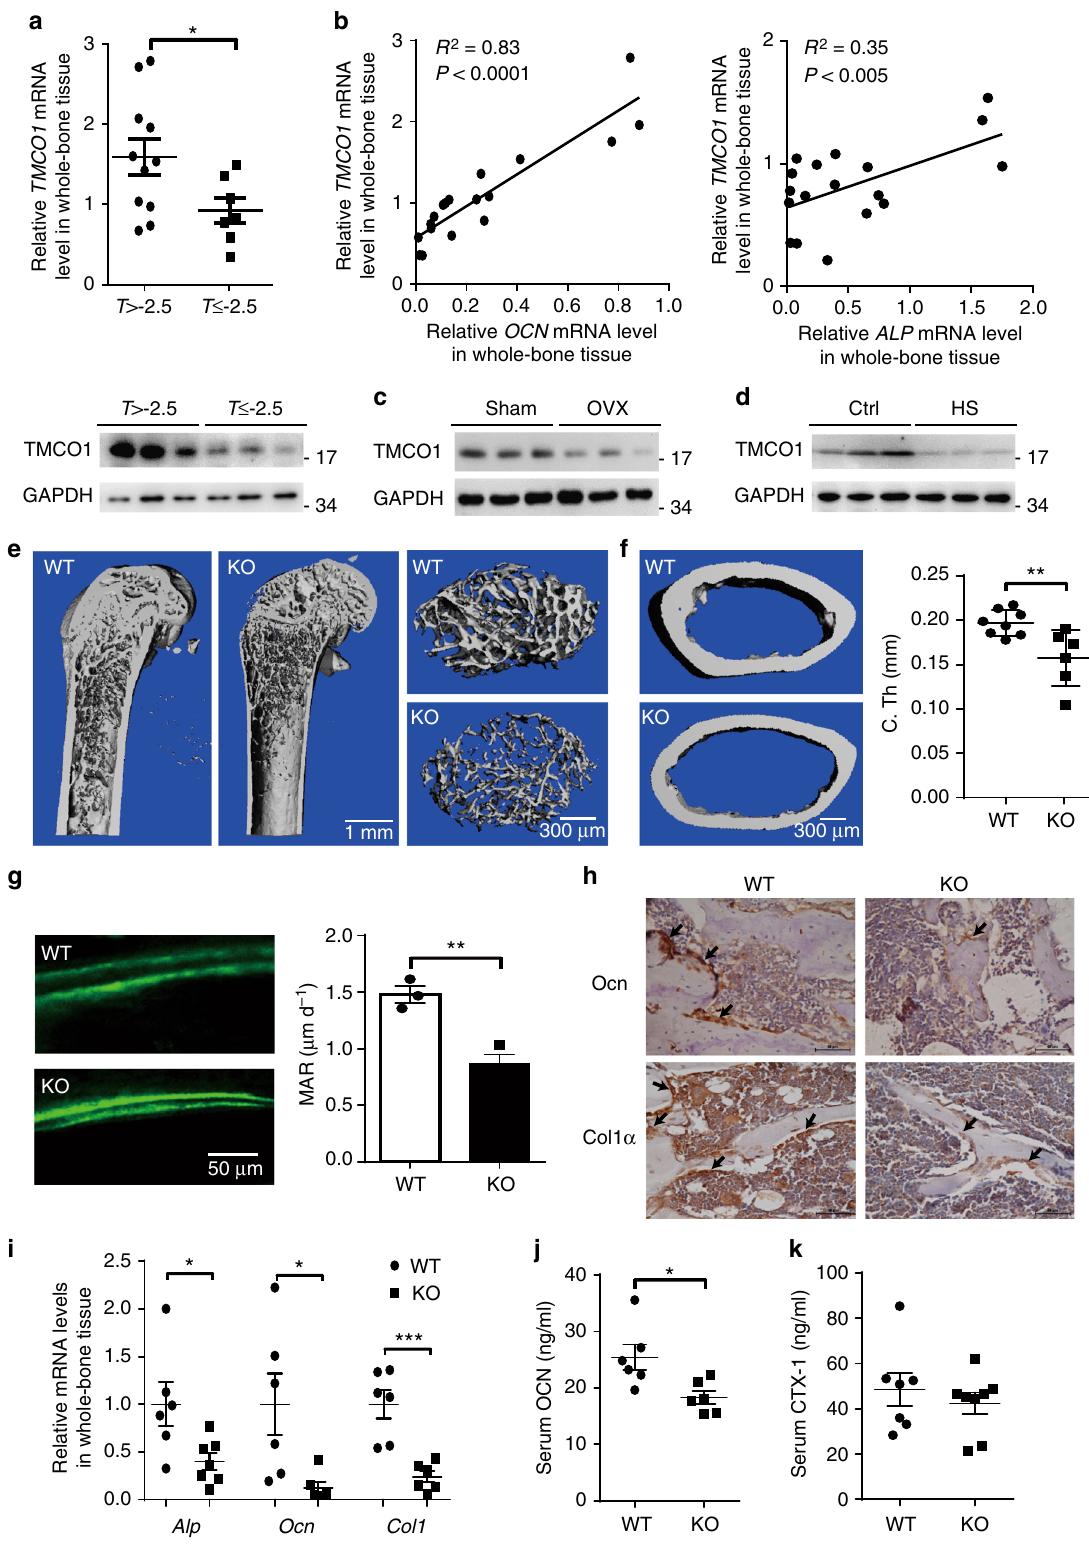
protein level during the process of osteoclast differentiation and the effect of TMCO1 de fi ciency on osteoclast differentiation. The result showed that TMCO1 expression had no changes in the process of osteoclast differentiation (Supplementary Fig. 3c). Moreover, TRAP staining and osteoclast marker genes showed no signi fi cant changes between WT and Tmco1 − / −